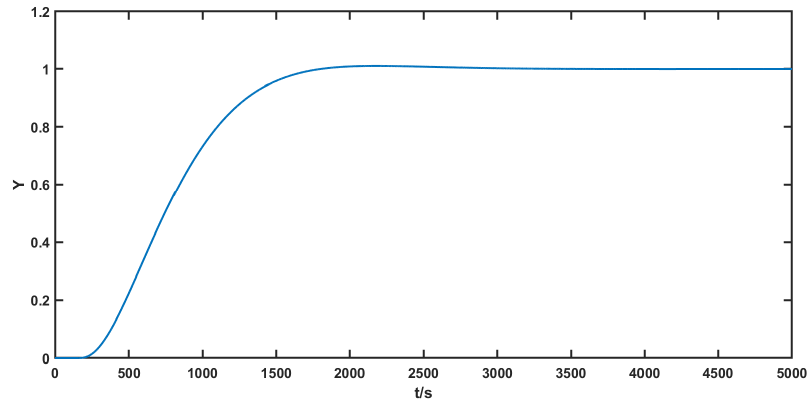
Figure 13. Process of Objective Function Optimization for ω c .